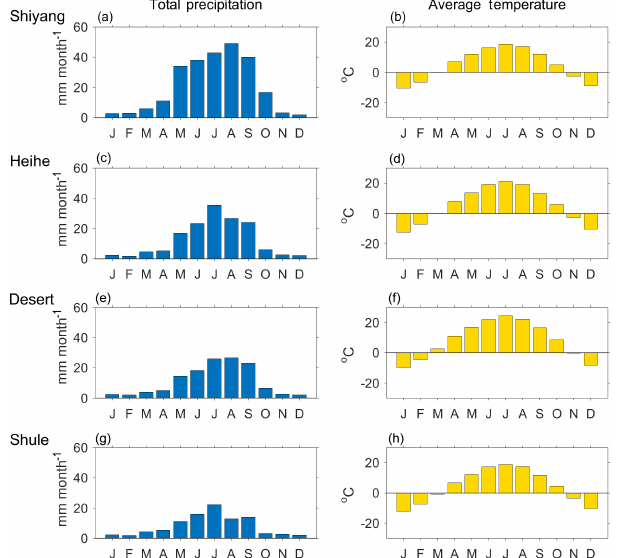
Figure 2. Monthly total precipitation and averaged temperature over four regions of the Hexi Corridor.